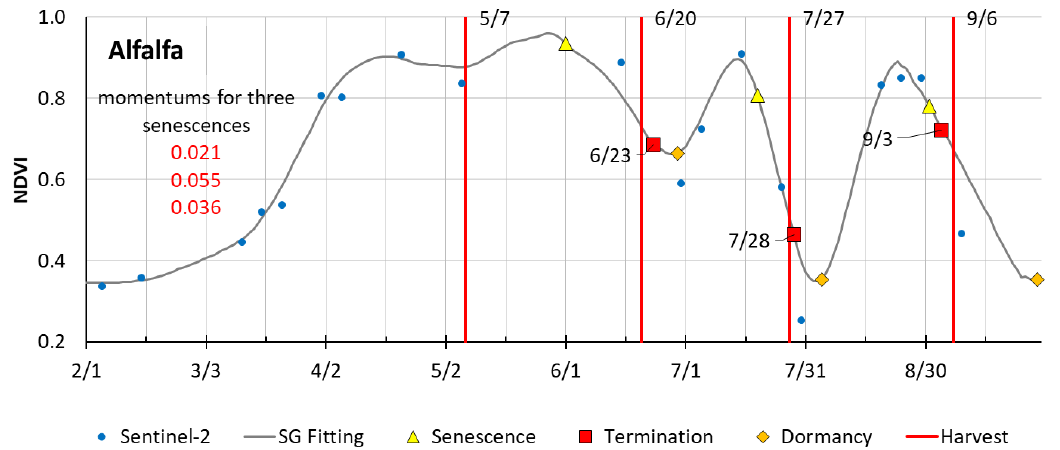
Figure 6. Three terminations were detected for the same alfalfa pixel as in Figure 5 (field #5-9) using the 2019. Sentinel-2 time-series. The first harvest on 7 May 2019, was missed since there were no clear Sentinel-2 observations from 7 May 2019 to 14 June